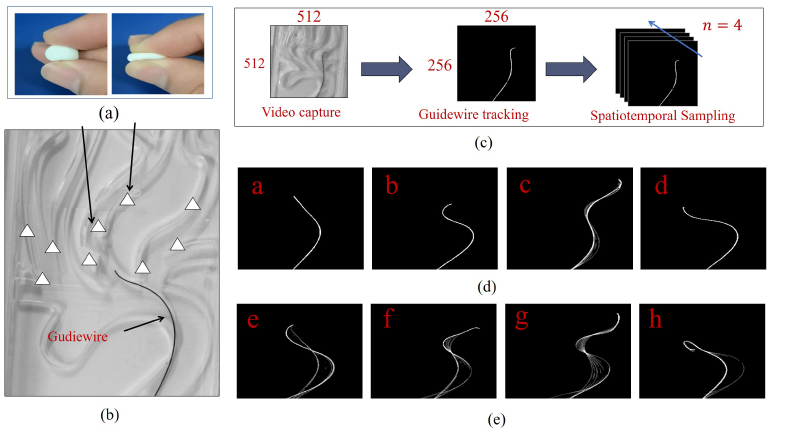
Figure 5. The vascular phantom and “hidden collisions” samples. ( a ) Soft white clay. ( b ) Vascular phantom. ( c ) Image processing and sampling. ( d ) Non-collision samples. ( e ) “Hidden collision”